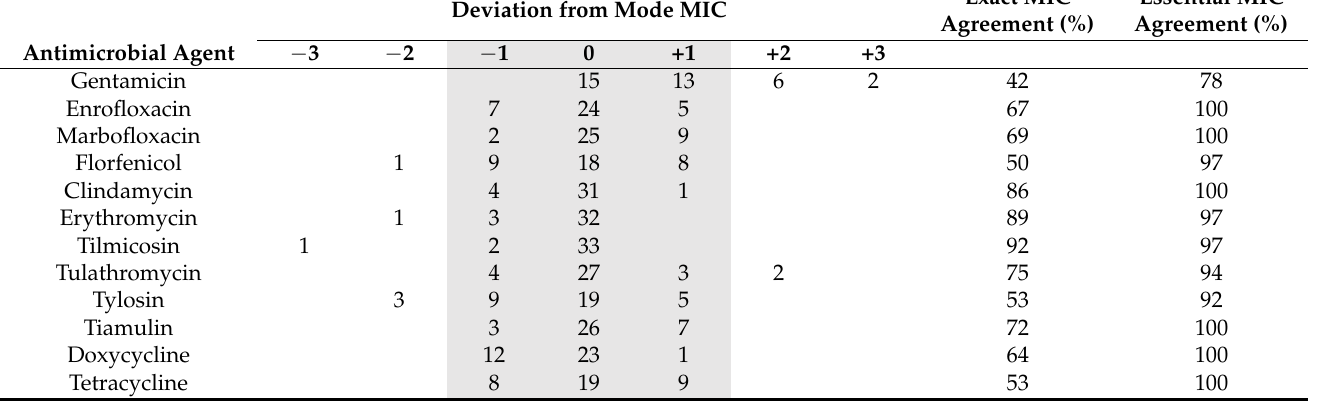
Table 7. Homogeneity of the MIC values of six M. hyorhinis field isolates tested in modified Friis broth, prepared with different batches of ingredients. The mode MIC and its deviations were determined, based on the results of the initial testing of the isolates (see Table 6). The grey-shaded area contains the MIC values accounting for the essential MIC agreement. Deviation from Mode